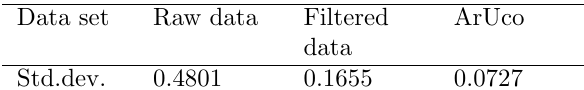
Table 1: The standard deviations of each data set con- sisting of geodesic distances on SO (3) are shown in degrees.